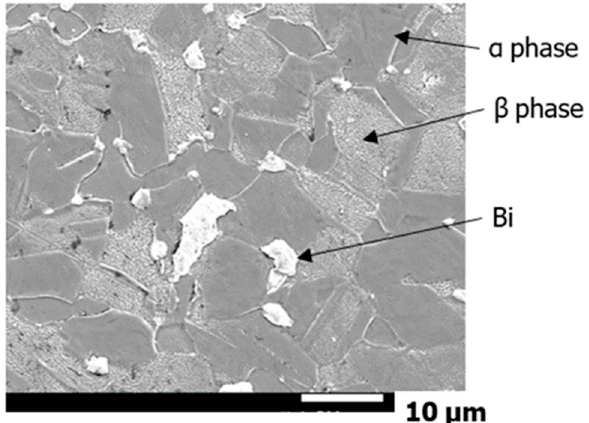
Figure 2. Bi, A material microstructure (SEM).